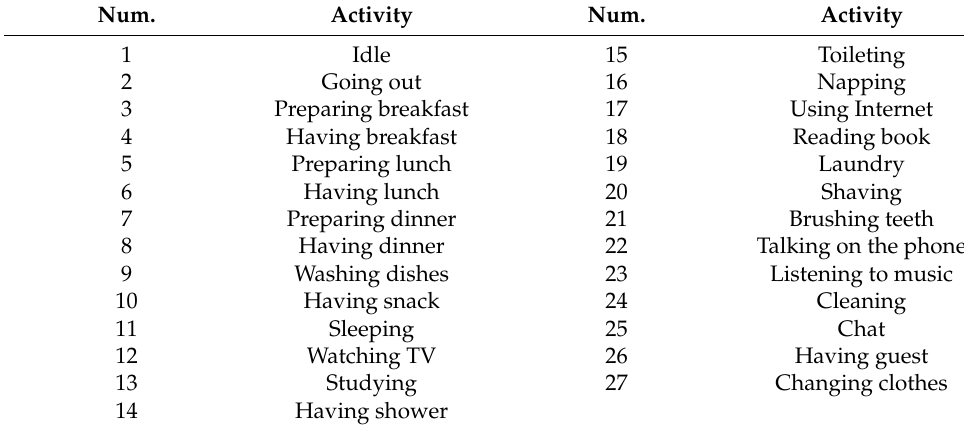
Table 2. Types of home activity